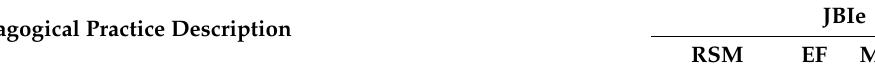
Table 3. Learning educational contexts and pedagogical practice descriptions for intervention studies, n =